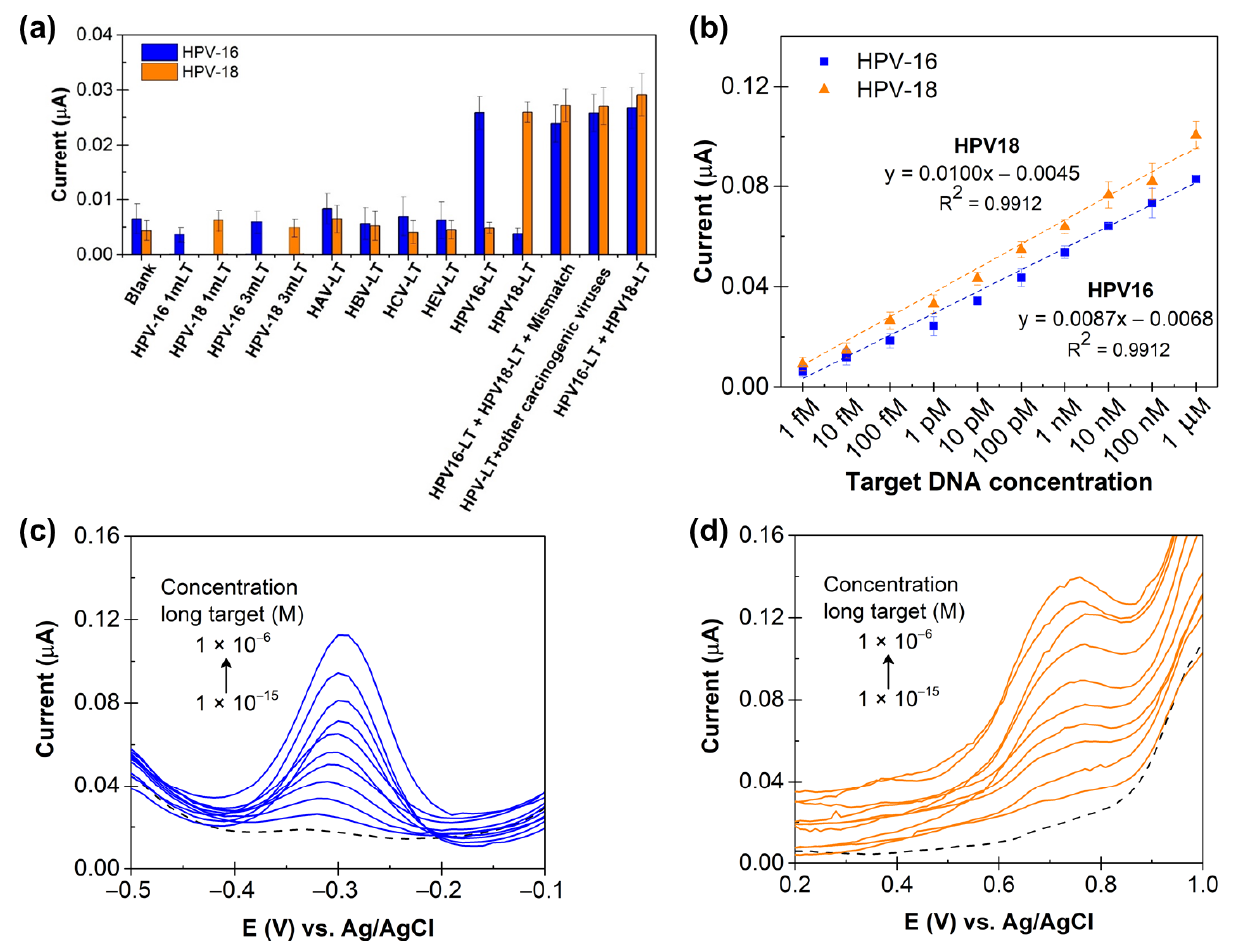
Figure 3 . Assay performance . ( a ) Specificity of the assay for HPV - 16 ( blue bar ) and HPV - 18 ( orange Figure 3. Assay performance. ( a ) Specificity of the assay for HPV-16 (blue bar) and HPV-18 (orange bar ) , tested with 1 pM complementary targets ( HPV16 - LT and HPV18 - LT ) , 1 pM mismatch DNA bar), tested with 1 pM complementary targets (HPV16-LT and HPV18-LT), 1 pM mismatch DNA targets ( HPV16 - 1m LT, HPV16 - 3m LT, HPV18 - 1m LT, HPV18 - 3m LT ) , and 1 pM non - complemen- targets (HPV16-1m LT, HPV16-3m LT, HPV18-1m LT, HPV18-3m LT), and 1 pM non-complementary tary targets ( HAV - LT, HBV - LT, HCV - LT, HEV - LT ). High current signals were obtained with sam- targets (HAV-LT, HBV-LT, HCV-LT, HEV-LT). High current signals were obtained with samples ples containing only the complementary targets ( HPV16 - LT and HPV18 - LT ) , a mixture of both com- containing only the complementary targets (HPV16-LT and HPV18-LT), a mixture of both comple- plementary targets ( HPV16 - LT + HPV18 - LT ) , mixture of both complementary targets with mis- mentary targets (HPV16-LT + HPV18-LT), mixture of both complementary targets with mismatch match targets ( HPV16 - LT + HPV18 - LT + mismatch ) and mixture of both complementary targets targets (HPV16-LT + HPV18-LT + mismatch) and mixture of both complementary targets with non- with non - complementary targets ( HPV - LT + other oncogenic viruses ). ( b ) Calibration curves for complementary targets (HPV-LT + other oncogenic viruses). ( b ) Calibration curves for HPV-16 HPV - 16 ( orange triangle ) and HPV - 18 ( blue square ) constructed from measurements of 1 fM to 1 µM of the respective complementary linear targets . Differential pulse voltammograms showing the (orange triangle) and HPV-18 (blue square) constructed from measurements of 1 fM to 1 µ M of the increasing trend in the current signal with the increase in the concentrations of the HPV - 16 ( c ) and respective complementary linear targets. Differential pulse voltammograms showing the increasing HPV - 18 ( d ) linear targets . Dashed lines show the blank signal . All current responses are presented trend in the current signal with the increase in the concentrations of the HPV-16 ( c ) and HPV-18 ( d ) as mean values ± standard deviation ( SD ) , n = 5 . linear targets. Dashed lines show the blank signal. All current responses are presented as mean values ± standard deviation (SD), n = Table 2 . Comparison of limit of detection (LOD) of other previously reported HPV-16/HPV-18 elec- trochemical DNA biosensors .